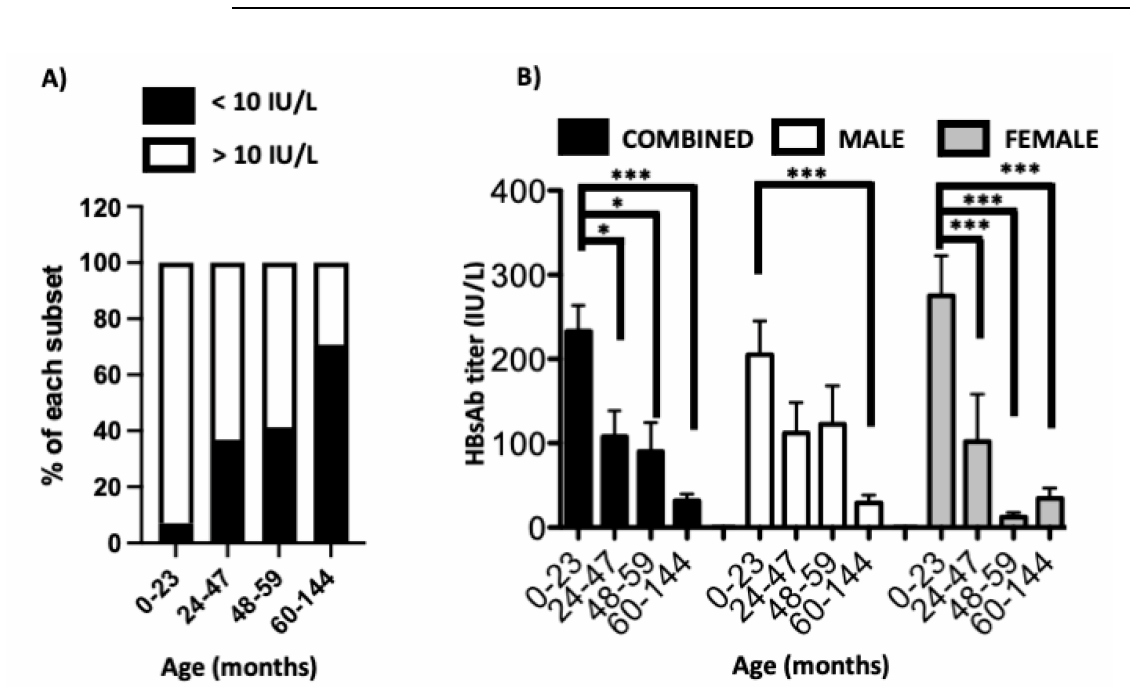
Figure 1. The proportion of children with significant antibody titers against HBV sharply decreases within years of immunization. ( A ). The proportion of children with humoral response above the 10 IU/L is illustrated for the four age groups. ( B ). The antibody level against HBV surface antigen [HBsAb] including both sexes (combined) and segregated by sex is indicated for the same age groups. * and *** represent p values below 0.05 and 0.001,